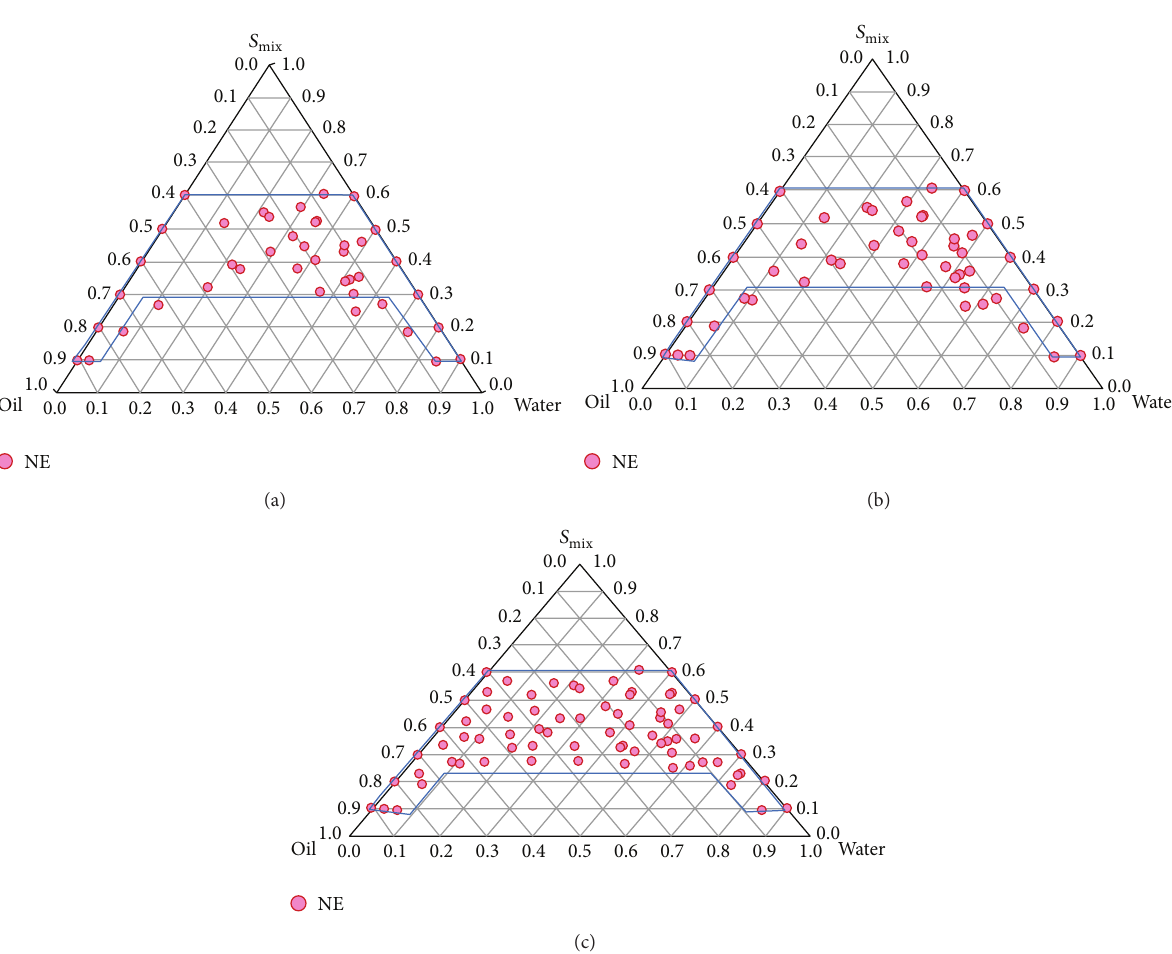
-1: 2, (b) 𝑆 -2 :1, and (c) 𝑆 -3: mix mix mix